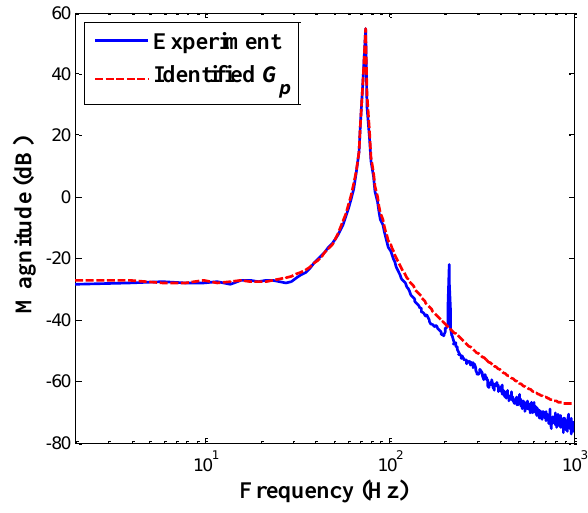
Figure 8. Frequency response of the gripping system.